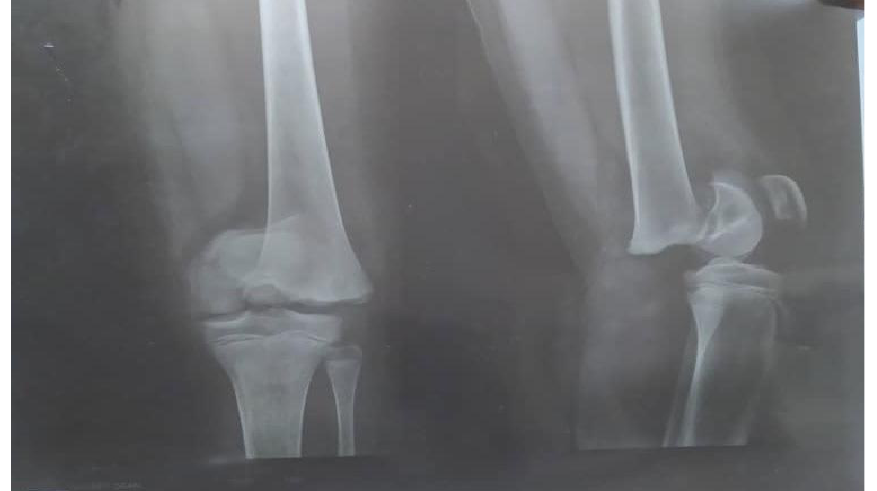
Figure 1. Plain X-ray of the left knee with mechanical non-union fracture. The initial therapeutic approach was a percutaneous crossed pins application (Figure 2).